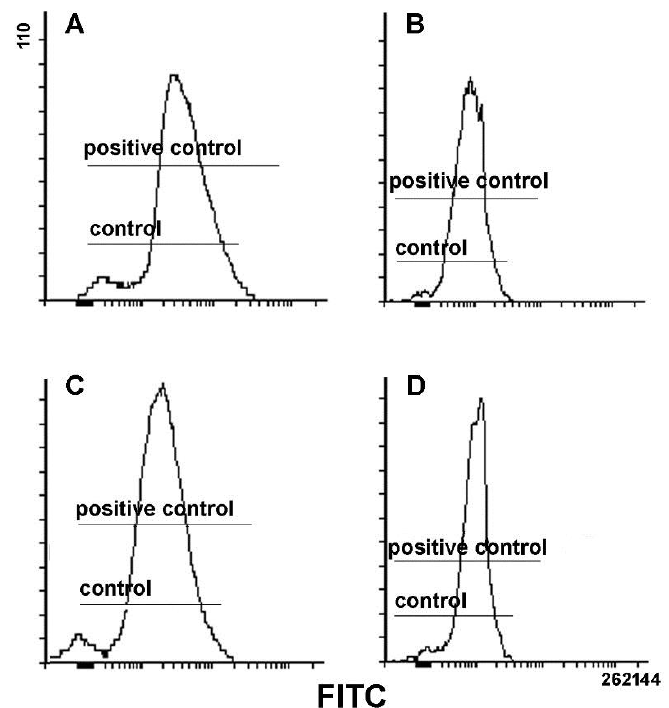
Figure 6. Representative plots showing reactive oxygen species (ROS) accumulation in gated alive MDA-MB231 cells exposed to total extracts ( A , C ) and 10K fractions ( B , D ) for 24 ( A , C ) and 48 h ( B , D ), compared to controls and H 2 O 2 -treated cells as positive controls. The x -axis reports the intensity of green fluorescence emitted by the dye 2’,7’-dichlorodihydrofluorescein, which is proportional to the amount of cytosolic ROS.